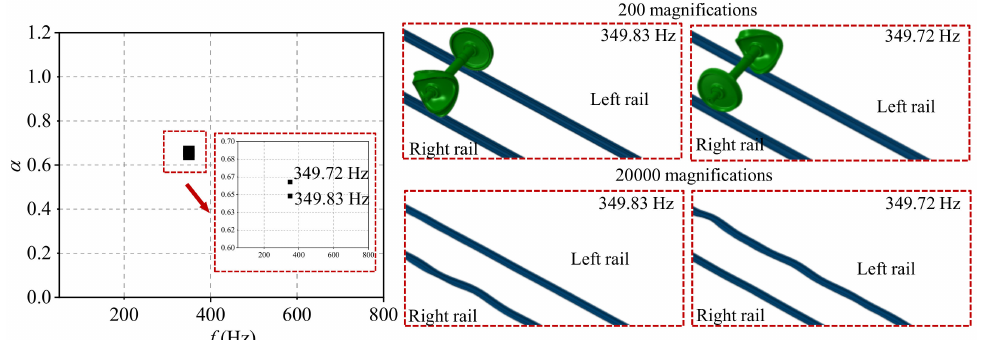
Figure 8. Distribution of real parts of eigenvalues and modal situations of the polygonal wheel– smooth rail system.